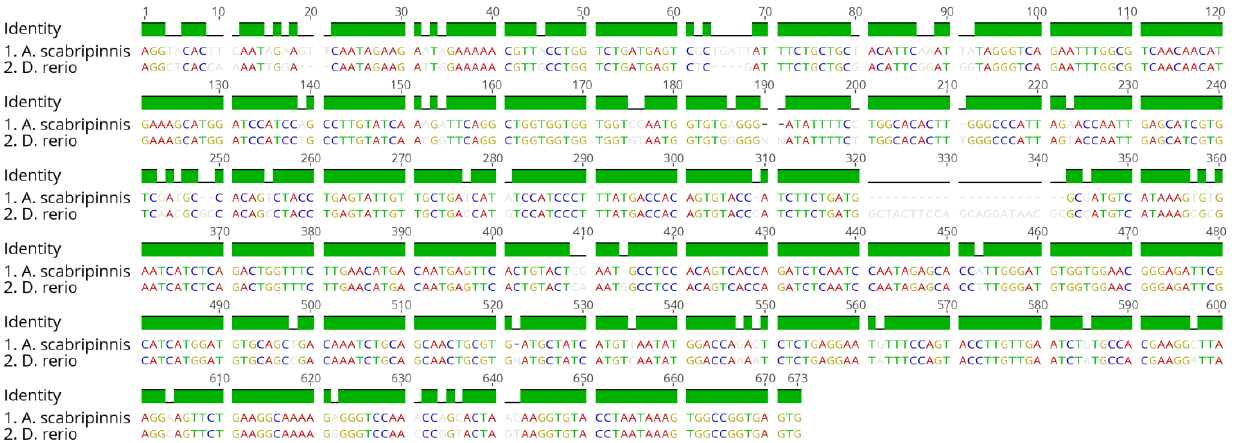
Figure 4. Alignment of the Tc1-Mariner transposon sequences of A . scabripinnis and D . rerio , showing a pairwise identity of 87%. The alignment was performed using Geneious v10.2.6.